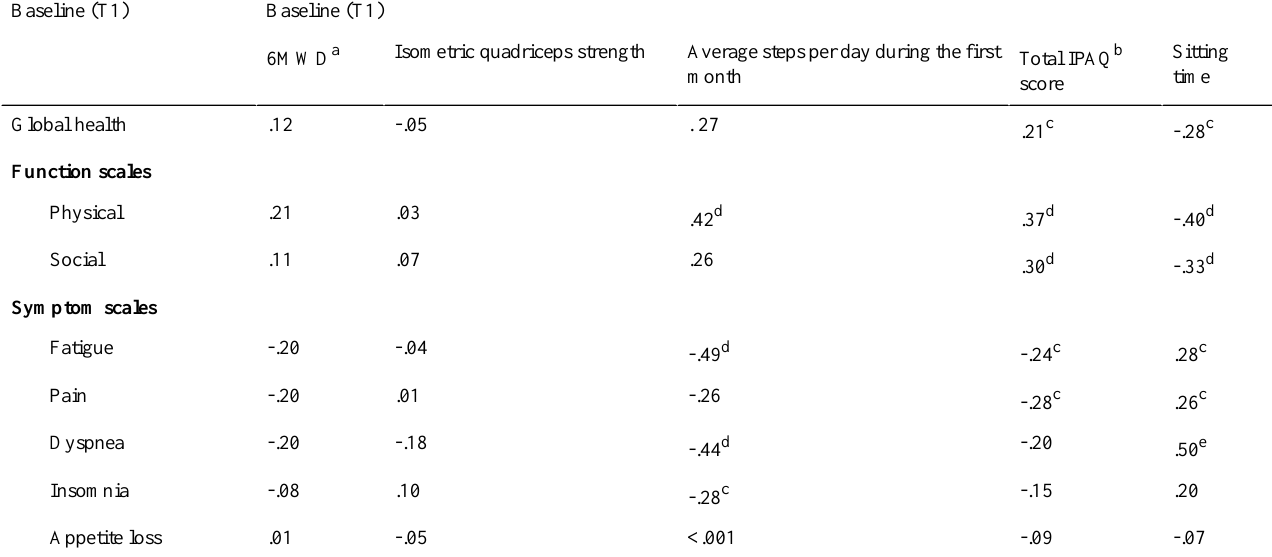
Table 3. Spearman correlations between physical activity and quality of life at baseline.